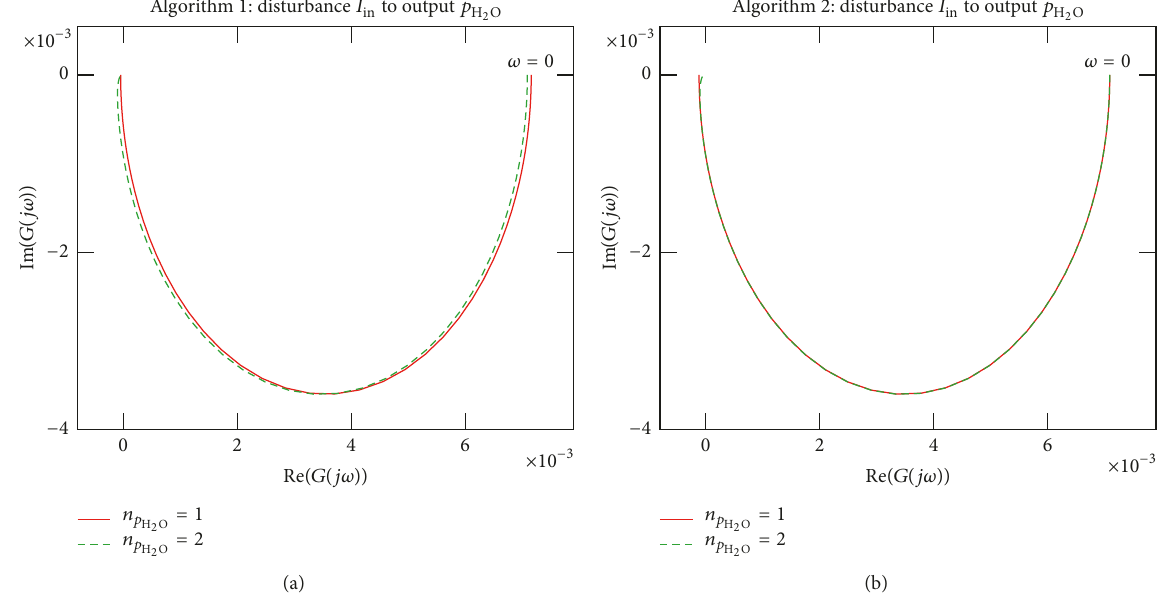
= 1 ) and full order ( 𝑛 = 2 ): reduction algorithm 1 (a) 𝑝 H 2 O H 2 O